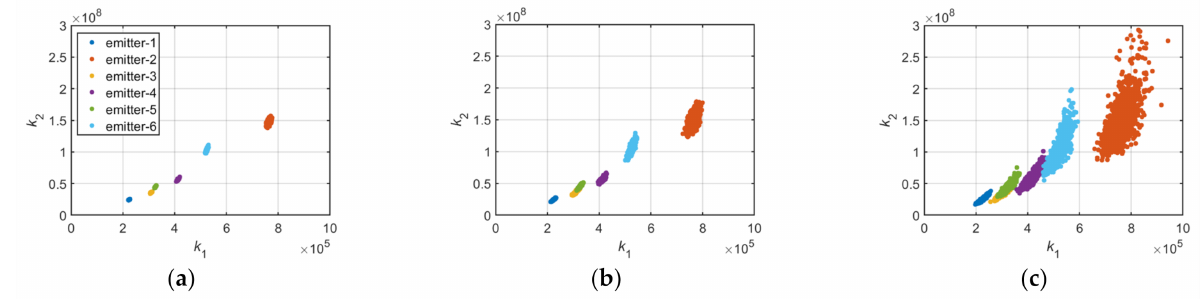
Figure 10. ( a ) k 1 , k 2 of six distinct emitters at 30 dB SNR; ( b ) k 1 , k 2 of six distinct emitters at 20 dB SNR; ( c ) k 1 , k 2 of six distinct emitters at 10 dB SNR.